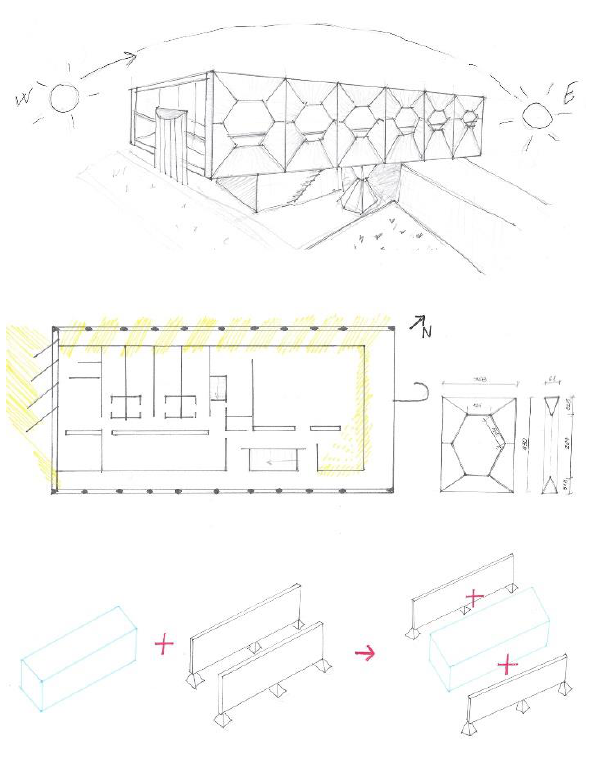
Figure 2. Gama Filgueiras Lima, Residência para Ministro de Estado (1965), Brasília. Volumetric and functional analysis